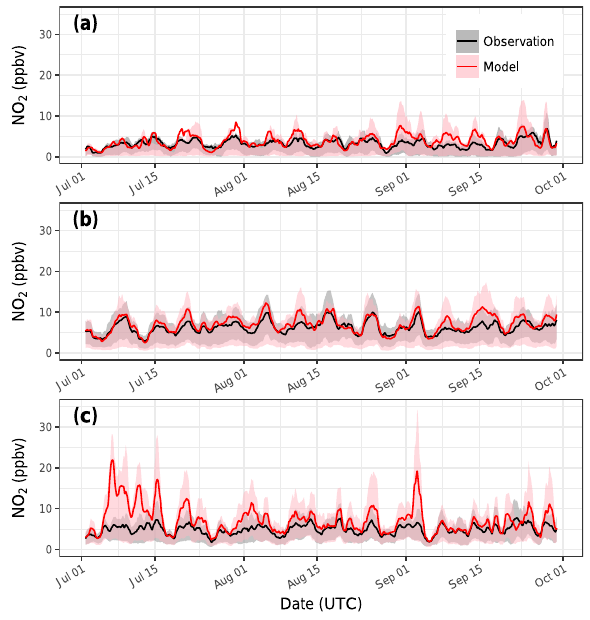
Figure 6. Same as Fig. 4 but for NO 2